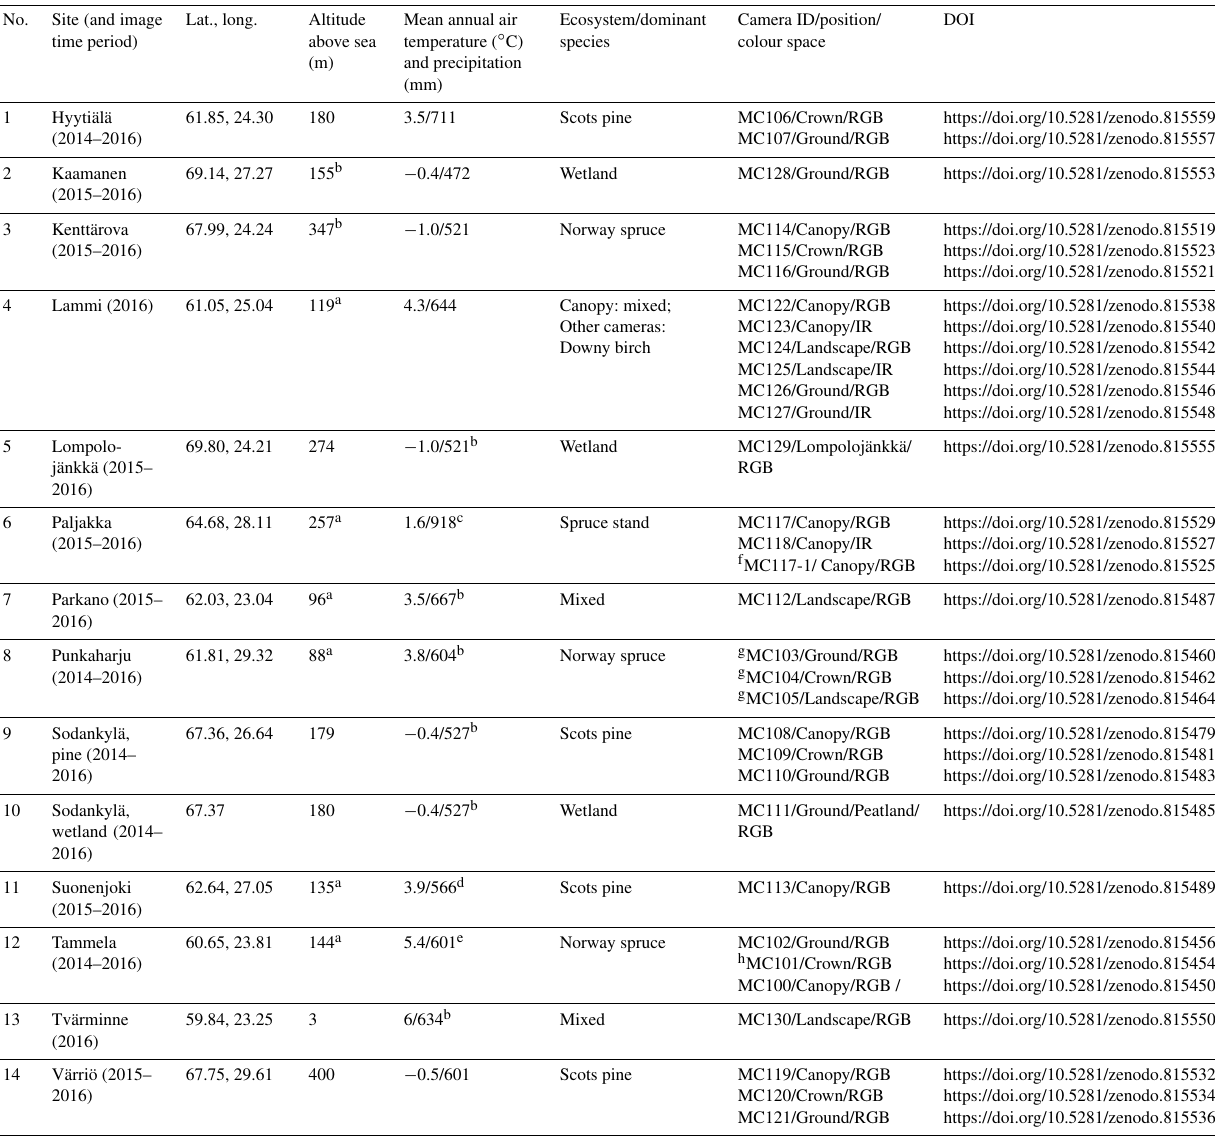
Table 1. Basic information about the camera sites, targets and the availability of images. Additional information of camera network and images from 2014 to 2016 can be found in Zenodo collection (https://doi.org/10.5281/zenodo.1066862). Coordinates are in decimal degrees